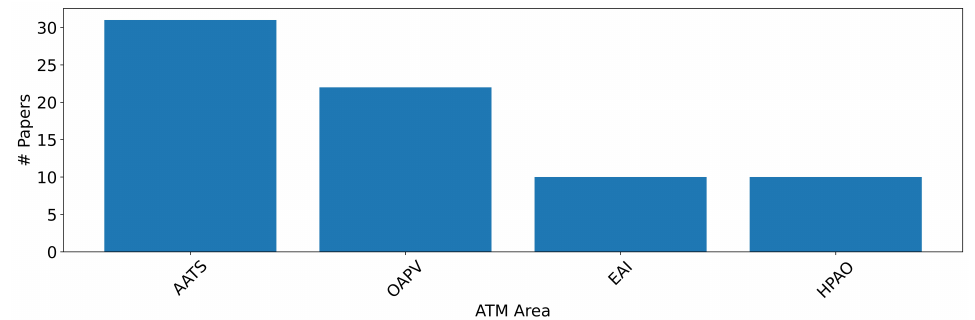
Figure 9. Paper count by ATM solution areas.